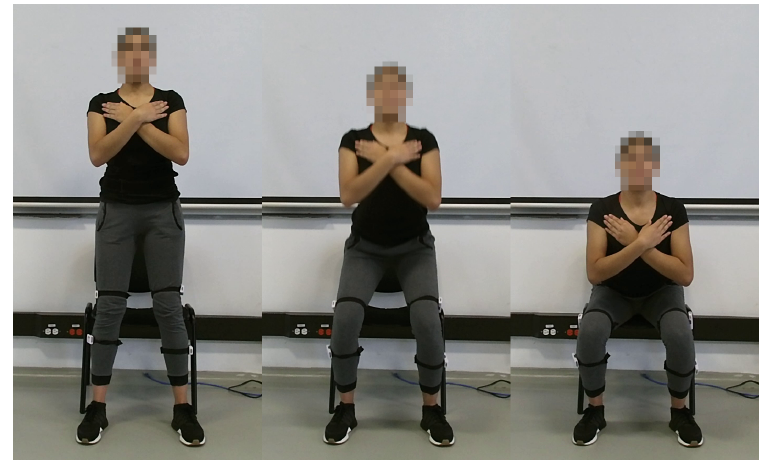
Figure 2. Recording sample.